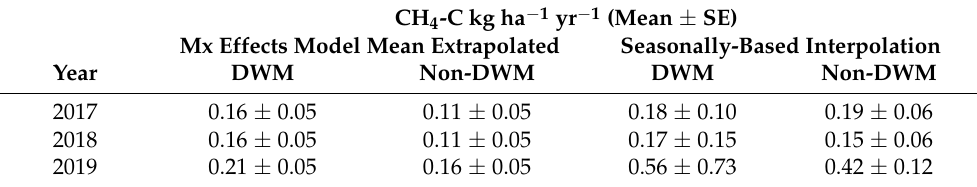
Table 4. Summary of comparison between the two annual CH 4 flux calculation methods. The SE asso- ciated with the seasonally-based interpolation represents the spatial heterogeneity among chambers. The mixed-effects model mean extrapolation error was derived from the model output error